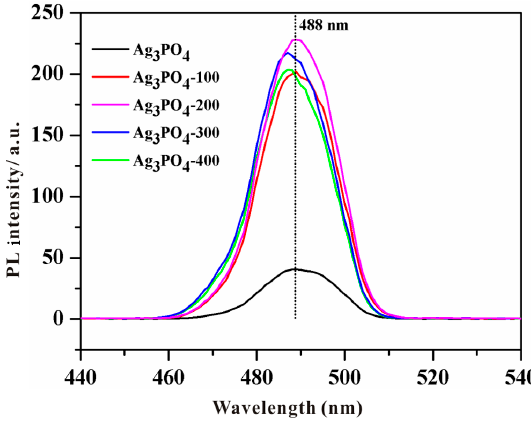
Figure 8. PL spectra of the as-prepared samples (excitation wavelength: 325 nm).